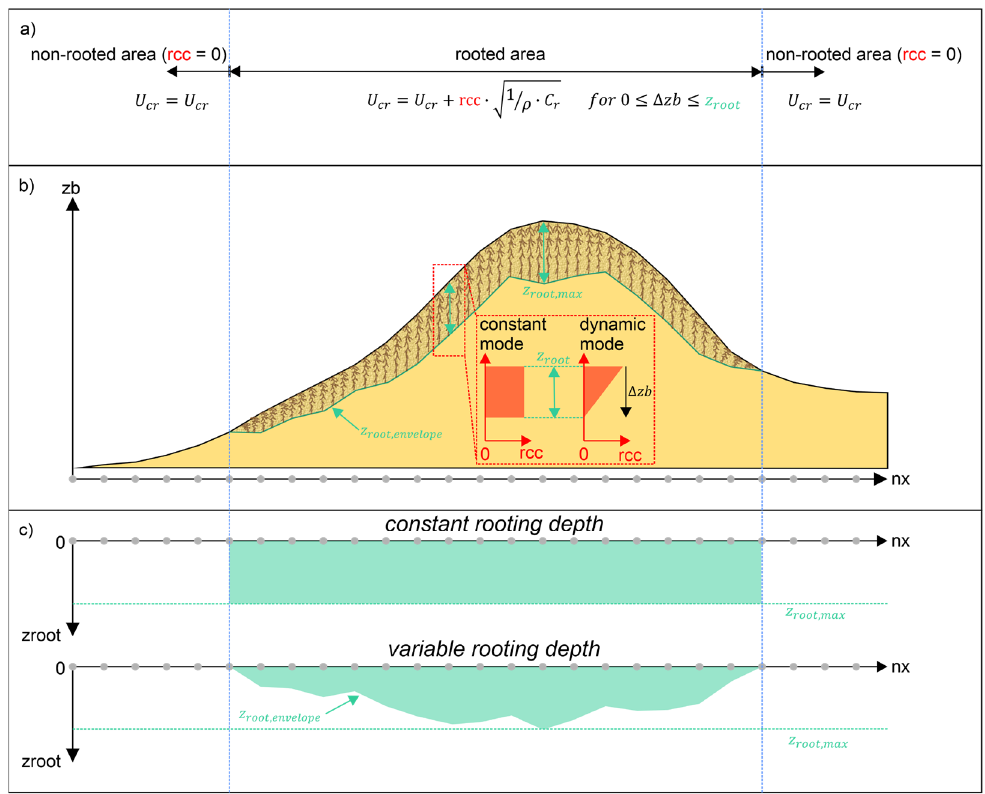
Figure 1. Extended root model: ( a ) The increase of the critical erosion velocity ( U cr ) in vegetated areas due to additional root cohesion. ( b ) A schematic sketch showing the increase of U cr simulated by the root model until the cumulated erosion ( Δ zb ) exceeds a user-defined rooting depth ( z root ). The root cohesion term is steered by a root calibration coefficient ( rcc ) which can be constant or linearly decreasing with the erosion depth (dynamic mode). ( c ) In addition to the first version [32], it is now possible to use spatially varying rooting depths.